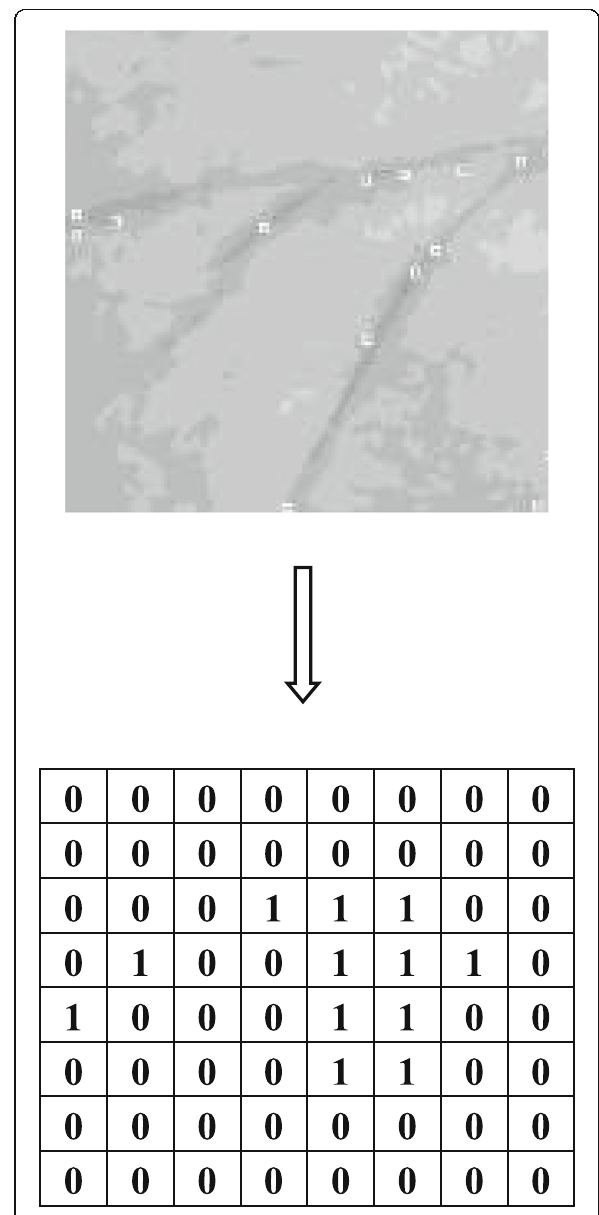
Fig. 5 Palm print with corners and its binary